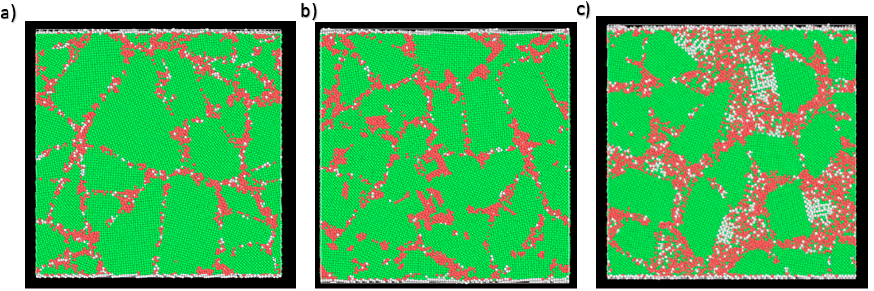
Figure 9. The microstructure evolution simulation at 100 ps for ( a ) Cu, ( b ) Ni, and ( c ) equimolar Cu-Ni alloy. The green atoms show FCC structure, the red atoms show HCP structure, and the white atoms show amorphous structure.